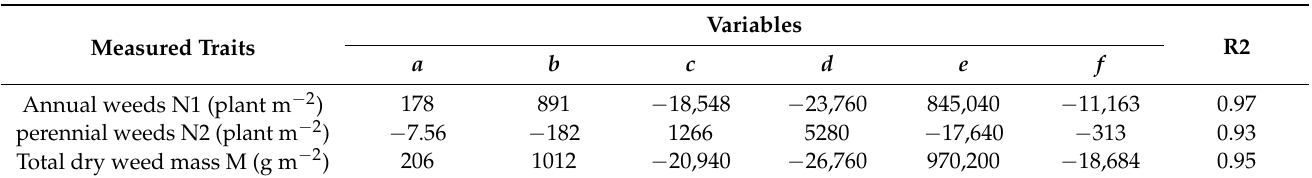
Table 2. Parameters of the regression equation for forecasting weed growth depending on water supply and soil nutrient